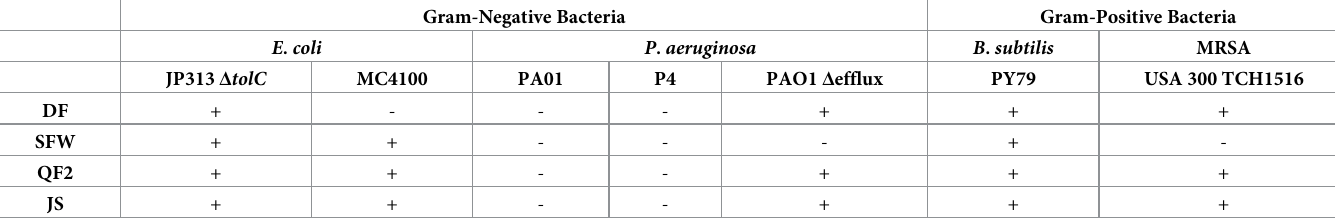
Plus signs indicate growth inhibition, while minus signs indicate pathogen growth.